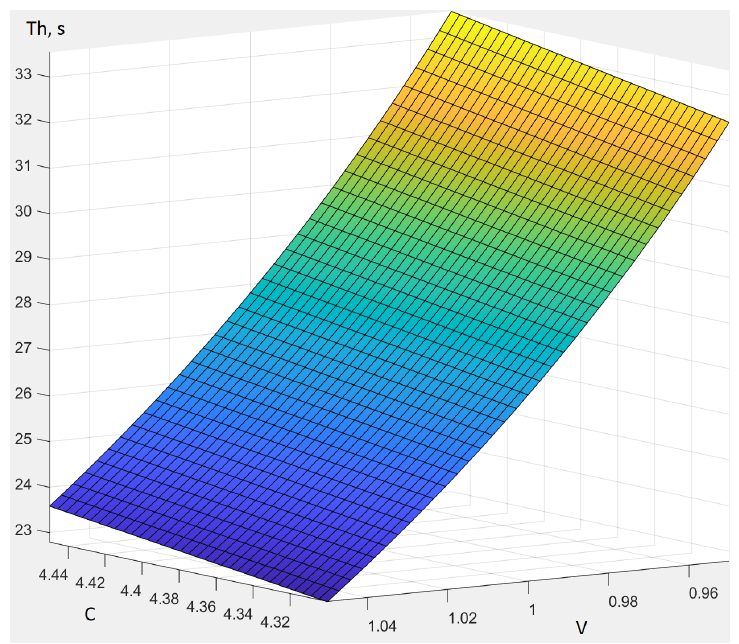
Figure 5. TCL heating cycle dependency on thermal capacitance and voltage.